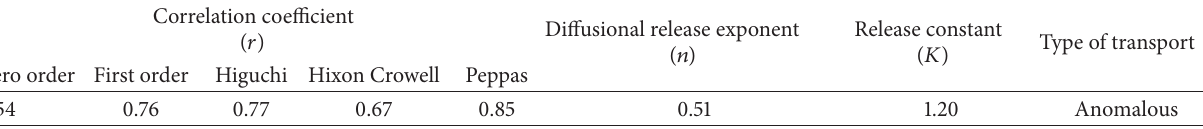
Table 3: Release kinetics of antioxidants from encapsulated algal